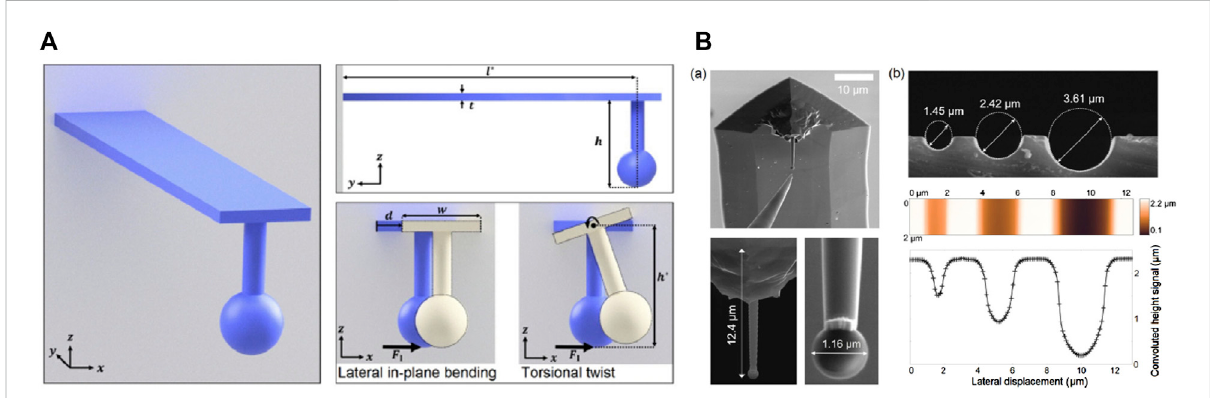
FIGURE 3 (A) Sketch ofacantileverbeam with rectangularcross-sectionand colloidal tipshowing therelevant dimensions t , l* , and h* ; (B) SEM imagesof a nanorobotically assembled high aspect ratio colloidal particle probe carrying a 1.16 µm particle at the tip and SEM images as well as AFM height images and pro fi les of the cavities used to investigate its capability to probe sidewalls. Reprinted with permission from (Zimmermann et al., 2019), Copyright 2018 Springer